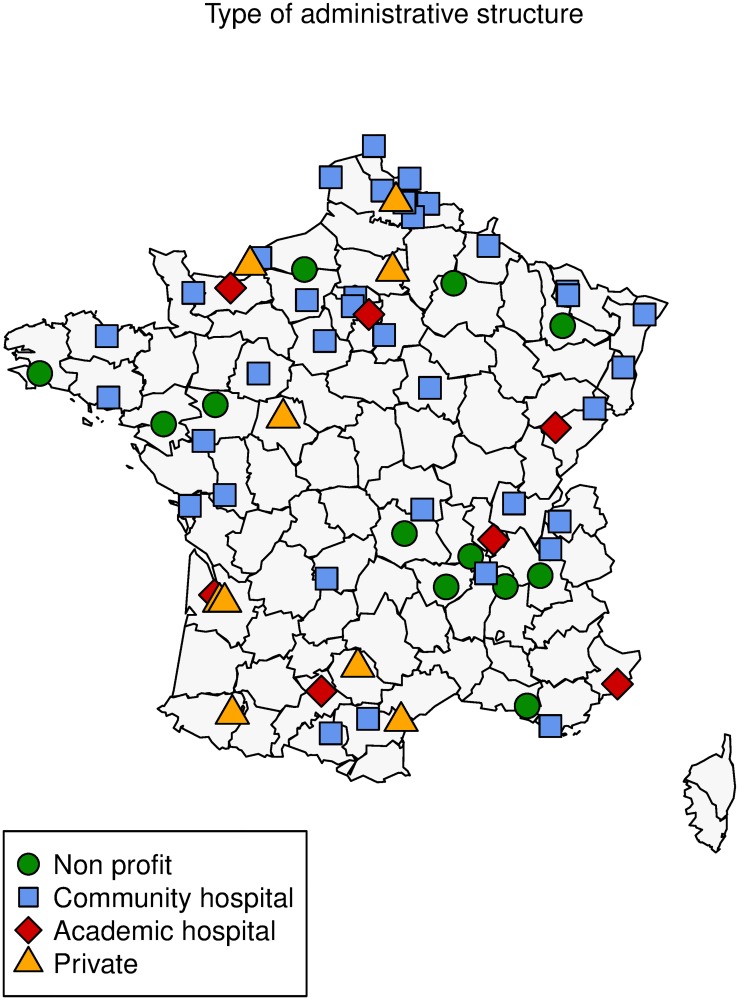
Type of administrative structures.